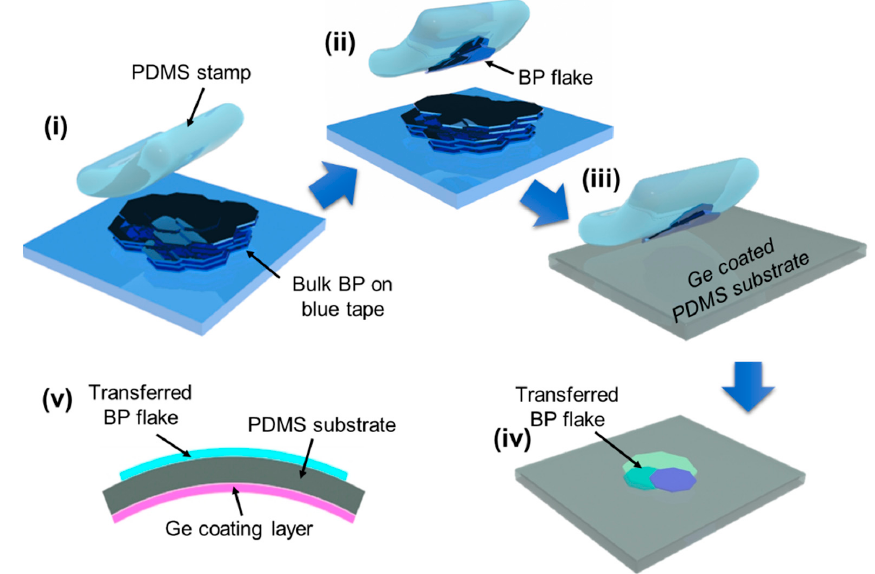
Figure 1. A schematic illustration of the sample preparation process on a Ge-coated polydimethylsiloxane (PDMS) substrate. ( i ) Mechanical exfoliation of black phosphorus (BP) flakes from bulk BP using blue tape, ( ii ) pick-up process of exfoliated BP flakes from the blue tape, ( iii , iv ) a transfer process of BP flakes onto the Ge-coated PDMS substrate, ( v ) cross-sectional view of the final structure under bending conditions.